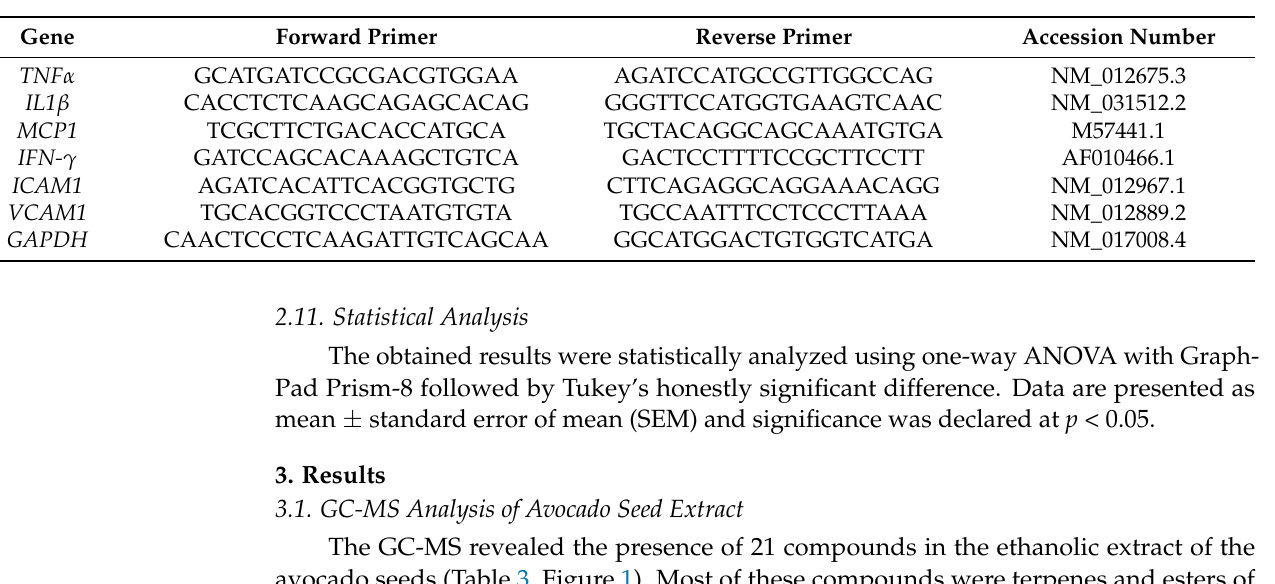
Table 2. Primers used for real-time PCR.